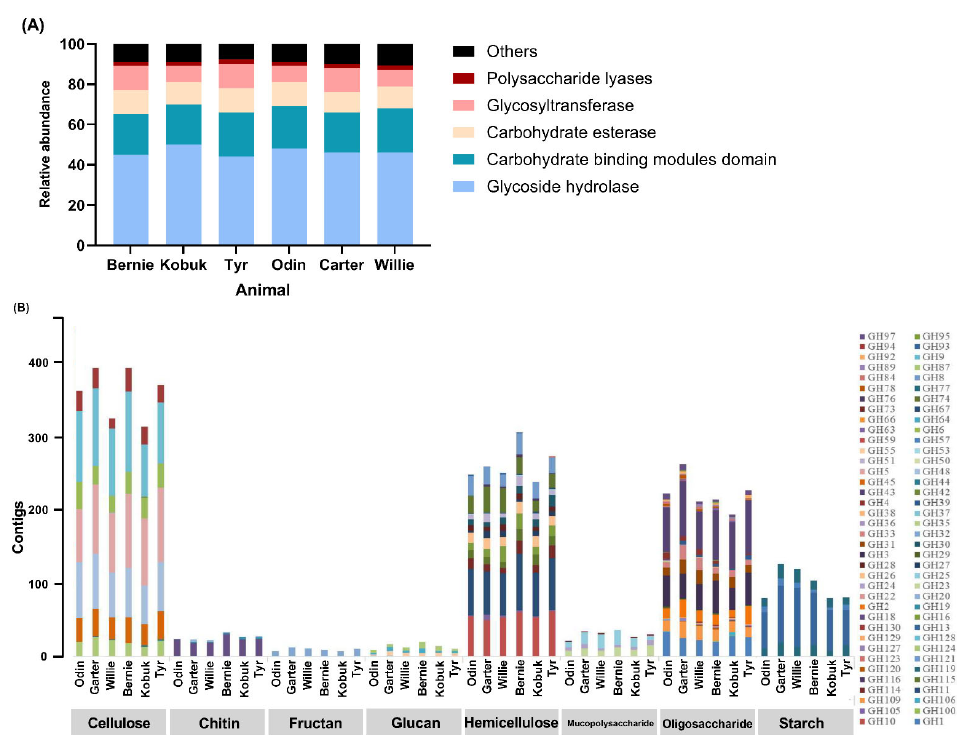
Figure 5. Mining of carbohydrate–active enzymes (CAZymes) for muskoxen fed triticale straw. ( A ) Comparison of predicted CAZymes classes: glycoside hydrolases (GHs), carbohydrate-binding modules (CBMs), carbohydrate esterases (CEs), glycosyl transferases (GTs), and polysaccharide lyases (PLs) in the rumen metagenomes. ( B ) Distribution of predicted GHs family responsible for cellulose, chitin, fructan, glucan, hemicellulose, mucopolysaccharide, oligosaccharide, and starch hydrolysis in rumen metagenome samples based on CAZy database.